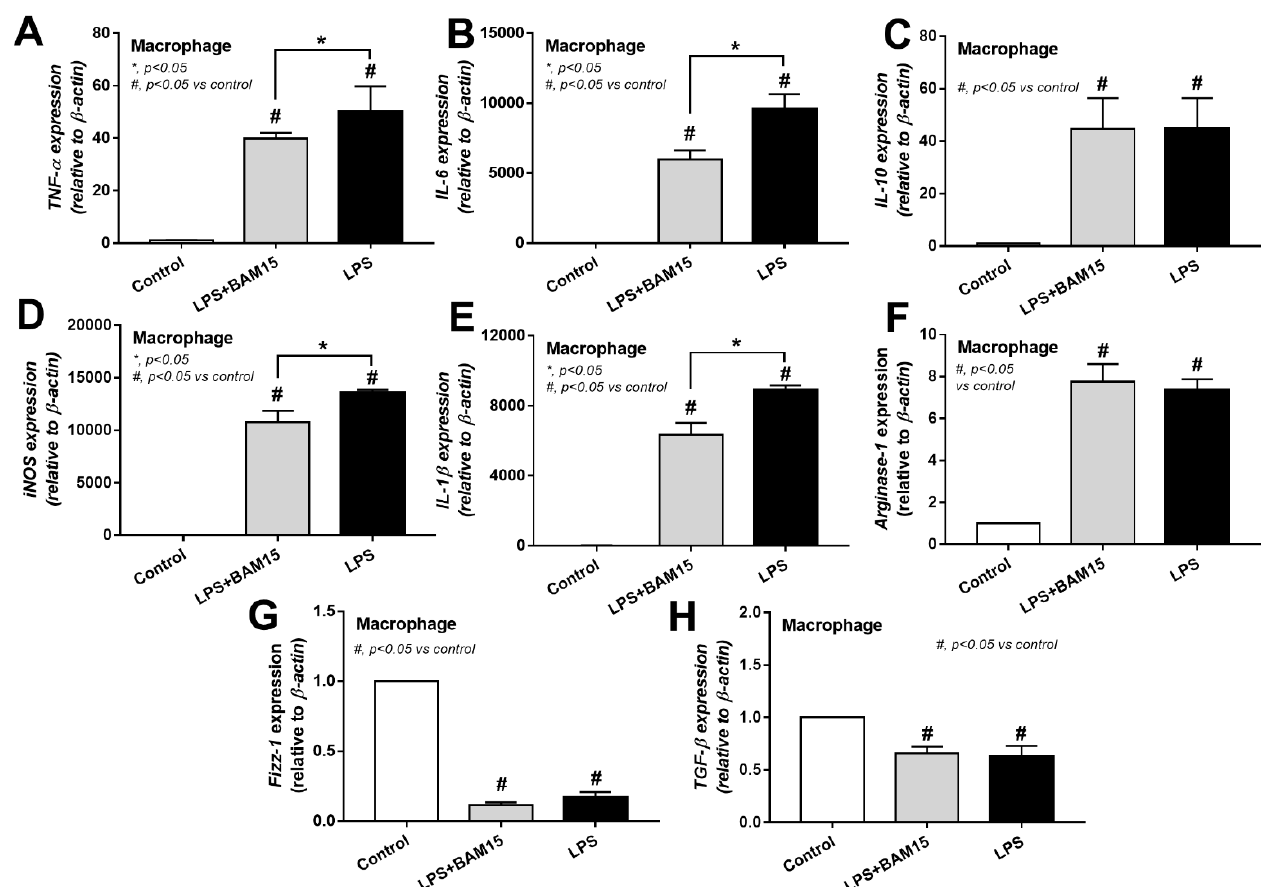
Figure 9. Characteristics of bone-marrow-derived macrophages after 24 h stimulation by LPS, with or without BAM15, in comparison with control media (media), as evaluated by gene expression of inflammatory cytokines ( TNF- α , IL-6 , and IL-10 ) ( A – C ), M1 macrophage polarization (pro-inflammation) ( iNOS and IL-1 β ) ( D , E ), and M2 macrophage polarization (anti-inflammation) (Arginase-1 , Fizz-1 , and TGF- β ) ( F – H ) are demonstrated. The data from macrophages with BAM15 without LPS are not demonstrated due to the non-difference from control group. #, p < 0.05 vs. control; *, p < 0.05 vs. the indicated groups as determined by ANOVA with Tukey’s analysis. #, p < 0.05 vs. control; independent triplicate experiments were performed.